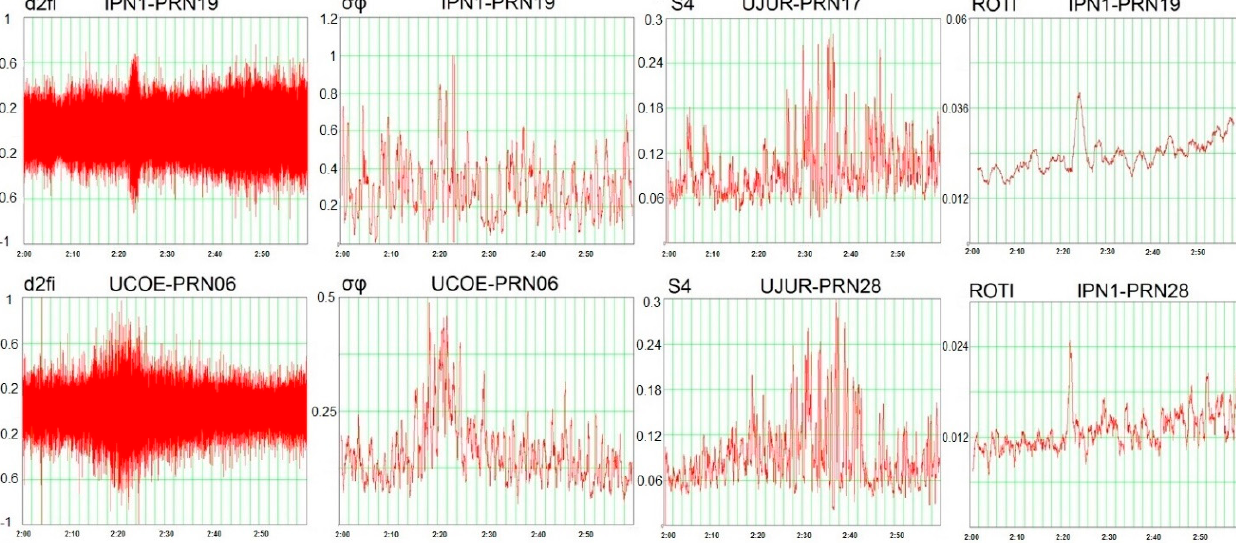
Figure 10. d2fi, σϕ , S4 and ROTI variations at LoSs between PRN02 and four receivers during 02–03 UT. Vertical line indicates the time of explosion. Table 3. Scintillation indices responses registered at different lines-of-sight.